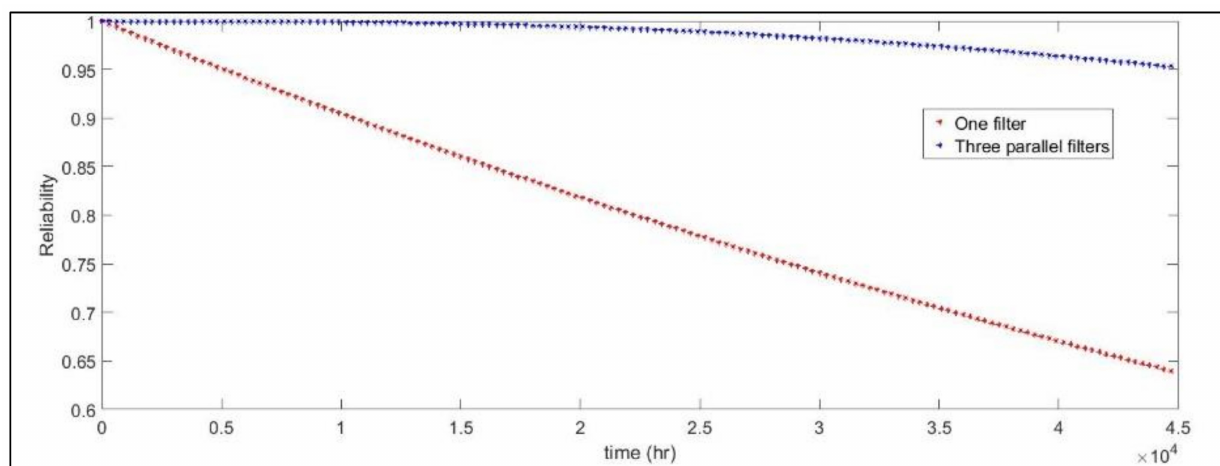
Figure 4. Reliability comparison for one air filter vs. three air